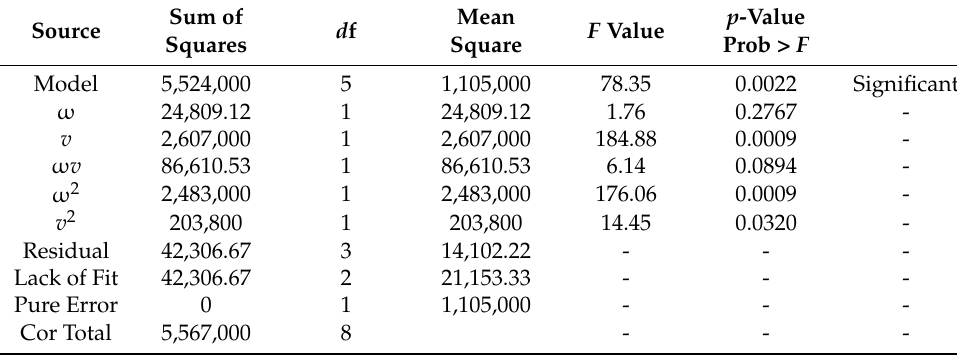
Table 5. ANOVA test